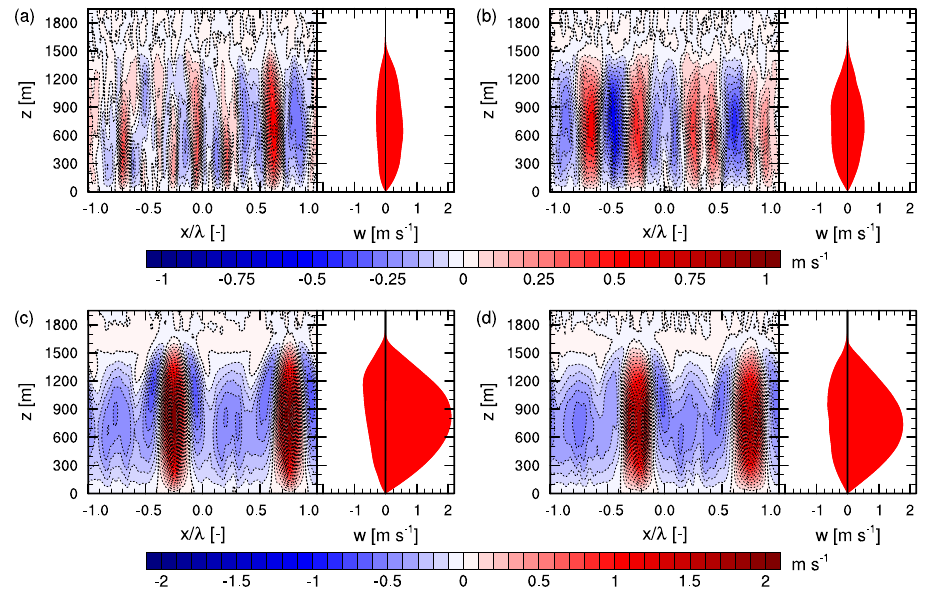
Fig. 8. Vertical wind velocity for the numerical experiments HOM (a) , HET (c) , WU2 (b) and WY2 (d) . The upper figures are based on a homogeneous surface forcing while the lower figures are connected to a heterogeneous surface forcing. The background wind was set to 0ms − 1 for the numerical experiments shown in the left column and 5ms − 1 in the positive y-direction for the numerical experiments shown on the right. Each figure consists of two panels. The first panel shows these variables averaged over the fourth hour of simulated time and the y-direction. The red area in the second panel shows the variability in the x-direction of the temporal and y averaged values. The x-coordinate is scaled by the length scale of heterogeneity, λ , which is twice the patch